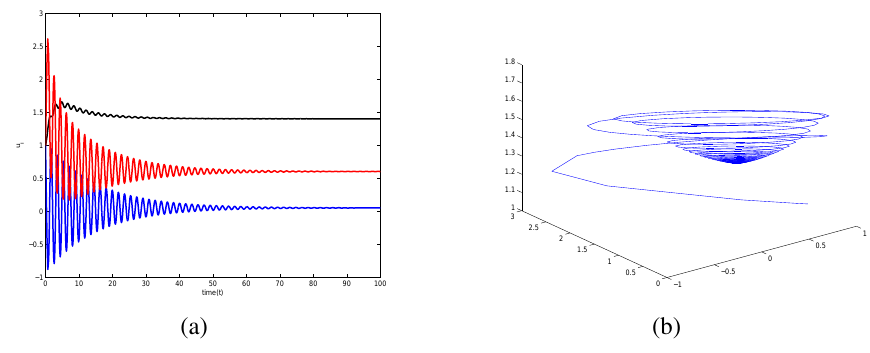
Figure 3: stable solutions and phase portrait of system 1 for τ = 0 . 45